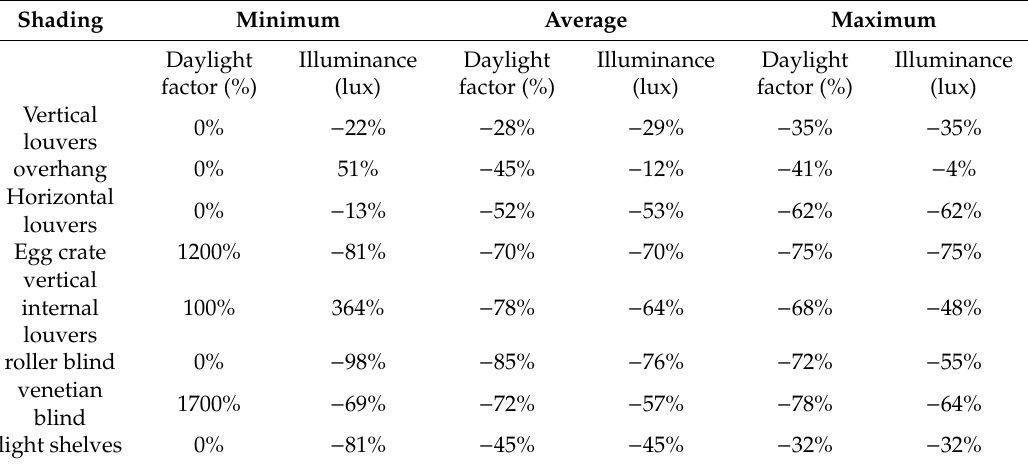
Figure 5. Different reductions of external and internal shadings compared to benchmark model Figure 5. Di ff erent reductions of external and internal shadings compared to benchmark model (without (without shades). shades). Table 12. Di ff erence in lighting levels by percentage in comparison to benchmark